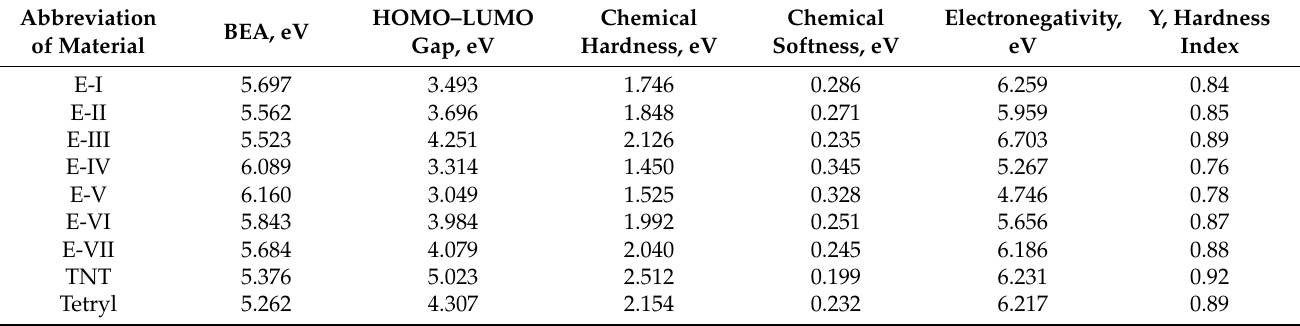
Table 2. Binding energy per atom (BEA) and the HOMO–LUMO gap of the compounds under investigation.